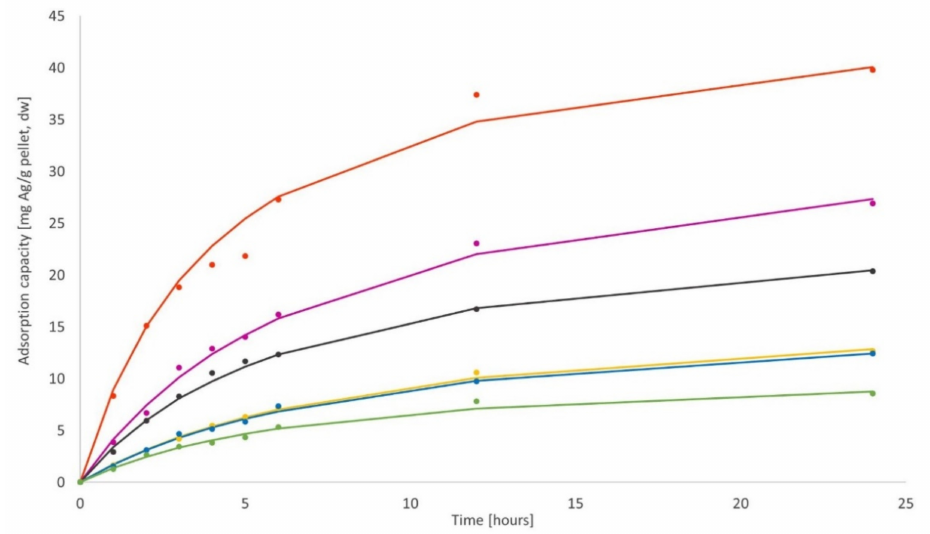
Figure 15. Ag adsorbed on different quantities (dry weight) of Cladosporium cladosporioides pellets. • : 0.0023 g; • : 0.0036 g; • : 0.0051 g; • : 0.0063 g; • : 0.0077 g; • : 0.0106 g. Symbols represent experimental data, while continuous lines represent simulation results of the adjusted pseudo-second-order model.